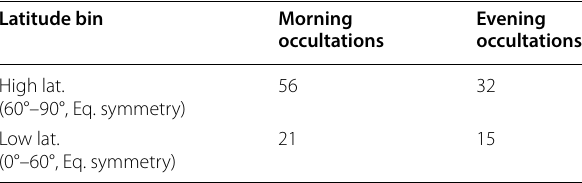
Table 1 Latitudinal distribution of the occultations assuming hemispheric symmetry Latitude bin Morning Evening occultations